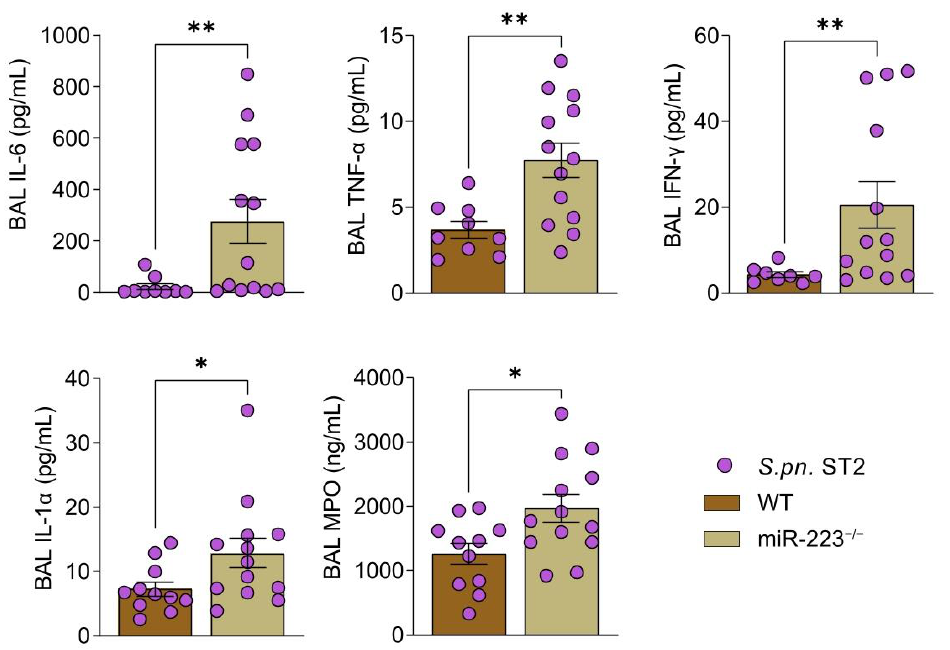
Figure 4. miR-223 − / − mice exhibit increased capacity of pro-inflammatory cytokine and chemokine production following S.pn. ST2 infection. Pro-inflammatory cytokines were quantified in the BAL of WT ( n = 11) and miR-223 − / − ( n = 13) mice 48 hpi using the LEGENDPlex Mouse Inflammation Panel (BioLegend, San Diego, CA, USA), whilst MPO was quantified using the MPO Mouse ELISA kit (Hycult Biotech, Uden, Netherlands). Mann-Whitney U test was performed to analyze statistical significance. * p < 0.05, ** p < 0.01; data display individual values and means, error bars represent SEM. BAL: bronchoalveolar lavage, S.pn. ST2: Streptococcus pneumoniae serotype 2, MPO: myelop- eroxidase .